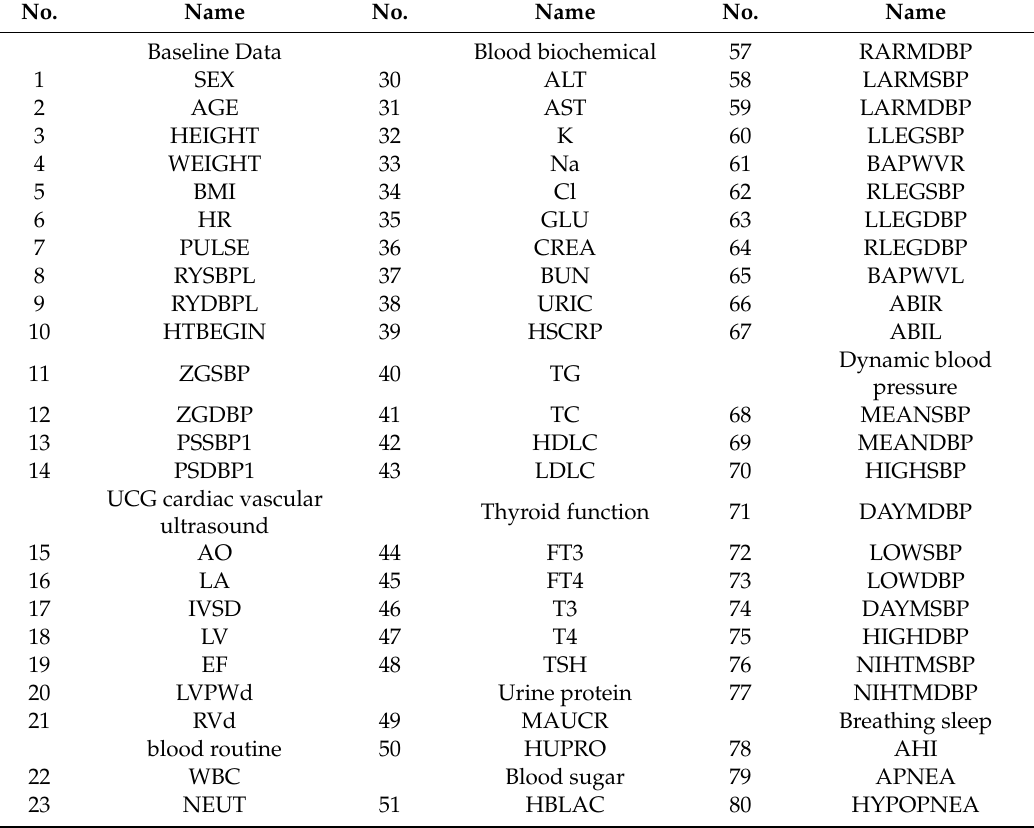
Table 1. Original